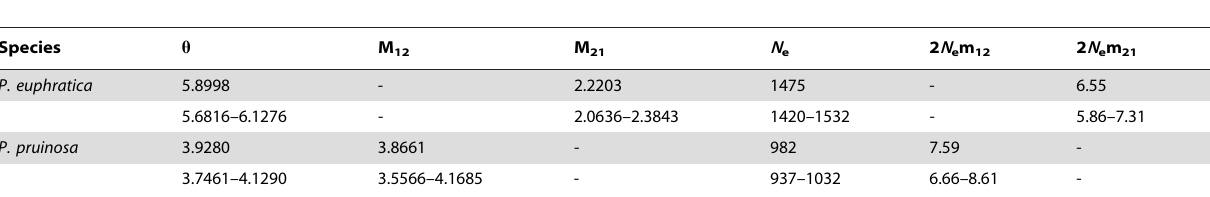
Table 3. Effective population sizes ( N e ) in P. euphratica and P. pruinosa , and effective migration rates ( N e m) between species, estimated by coalescent theory and a maximum-likelihood-based